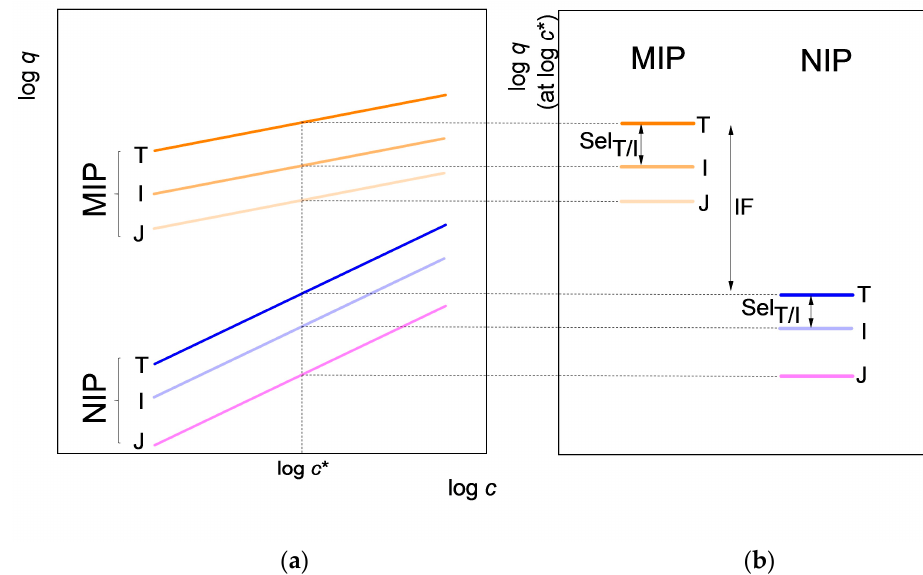
Figure 1. ( a ) Schematic isotherms of three compounds on an imprinted polymer (MIP) and on its control polymer (NIP). The template of the MIP is T, while I and J are compounds related to T; ( b ) the selectivity ladders of the MIP and the NIP, respectively, as derived from the isotherms. Arrows show the imprinting factor (IF) and the selectivity for the template T against compound I (Sel T/I ), respectively. Note that the selectivity of the MIP and of the NIP, respectively, are different.